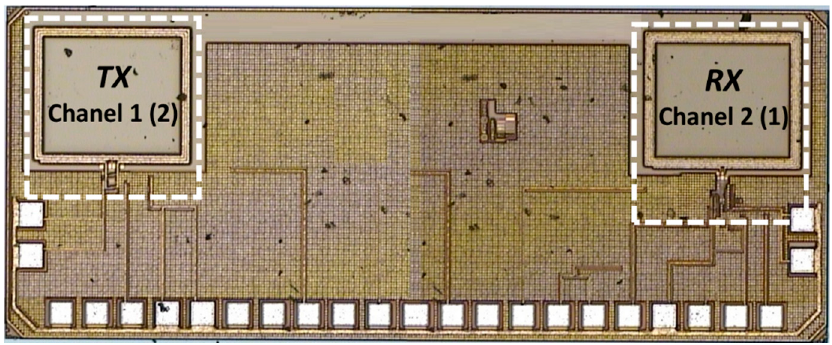
Electronics 2020 , 9 , 943 Figure 20. Die photograph of the isolated data transfer system chip. Figure 20. Die photograph of the isolated data transfer system chip.